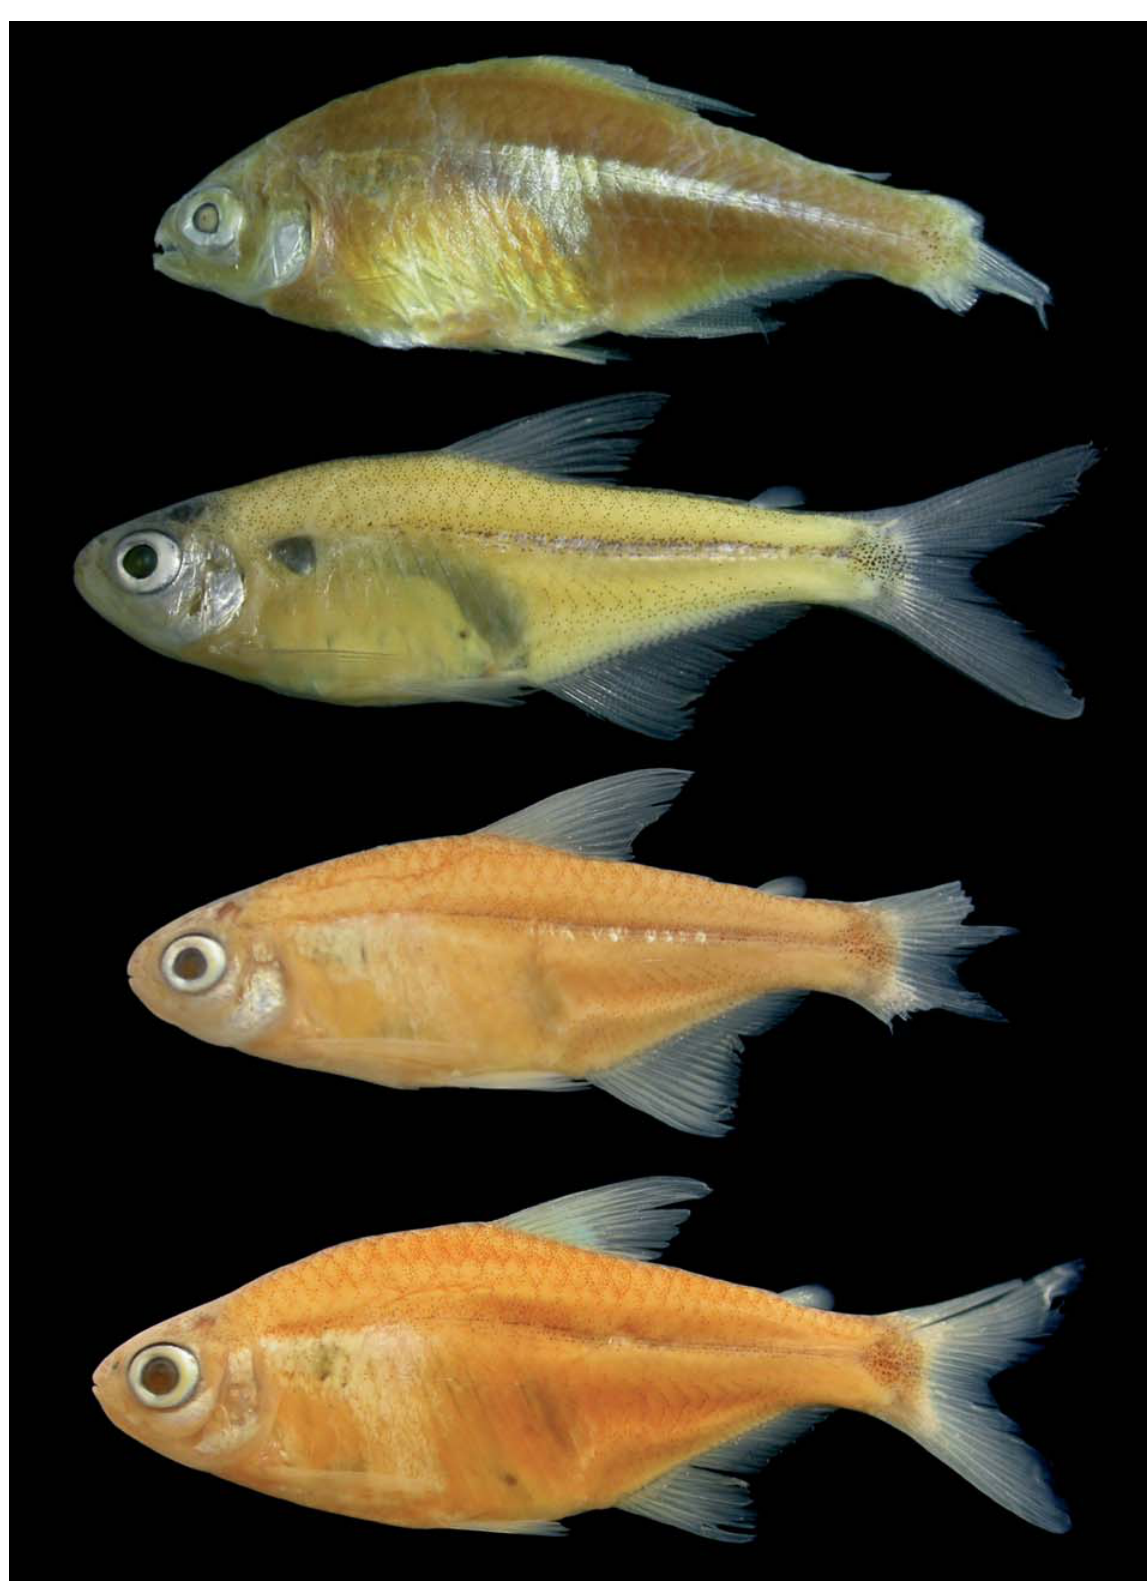
Fig. 1. Odontostilbe pulchra , syntype MNHN 0000-9593, female 28.7 mm SL (top), a specimen INHS 40101, male 32.3 mm SL from Trinidad (middle top), and specimens MCP 38863, male 28.6 mm SL (middle bottom), and female 32.5 mm SL (bottom) from río Orinoco